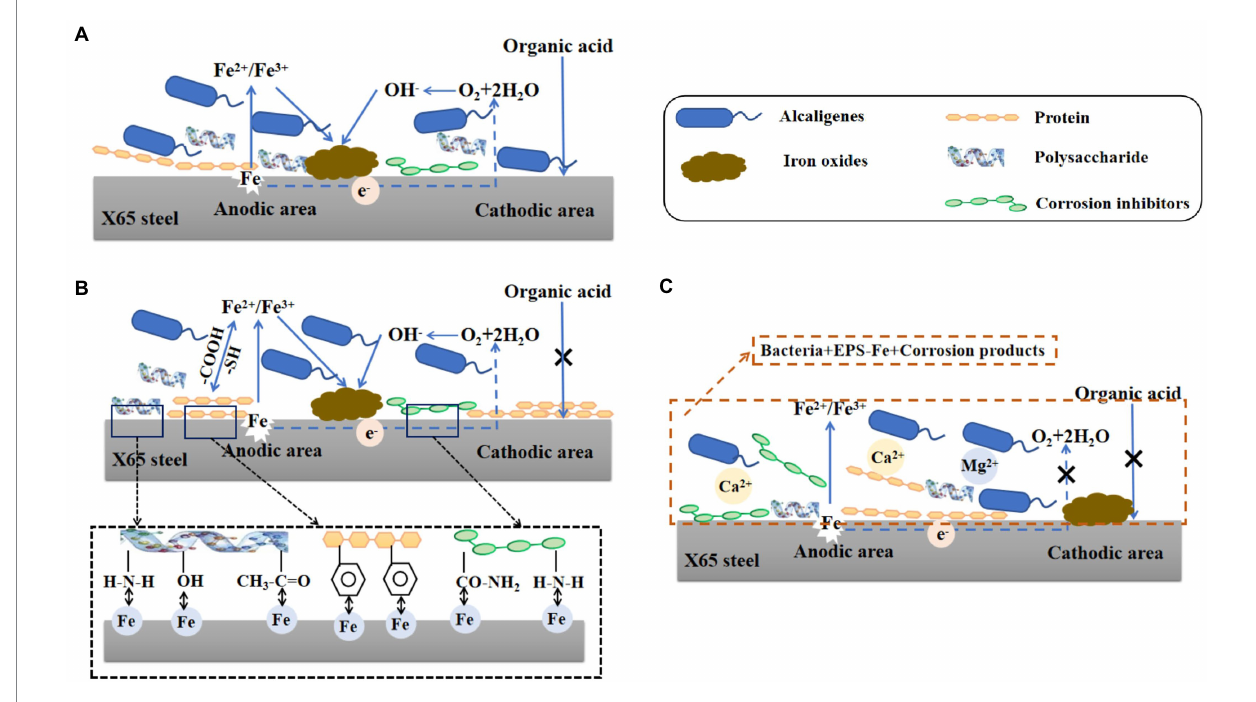
FIGURE 10 Schematic diagram of the modeled corrosion mechanism of X65 steel by Alcaligenes sp. in different